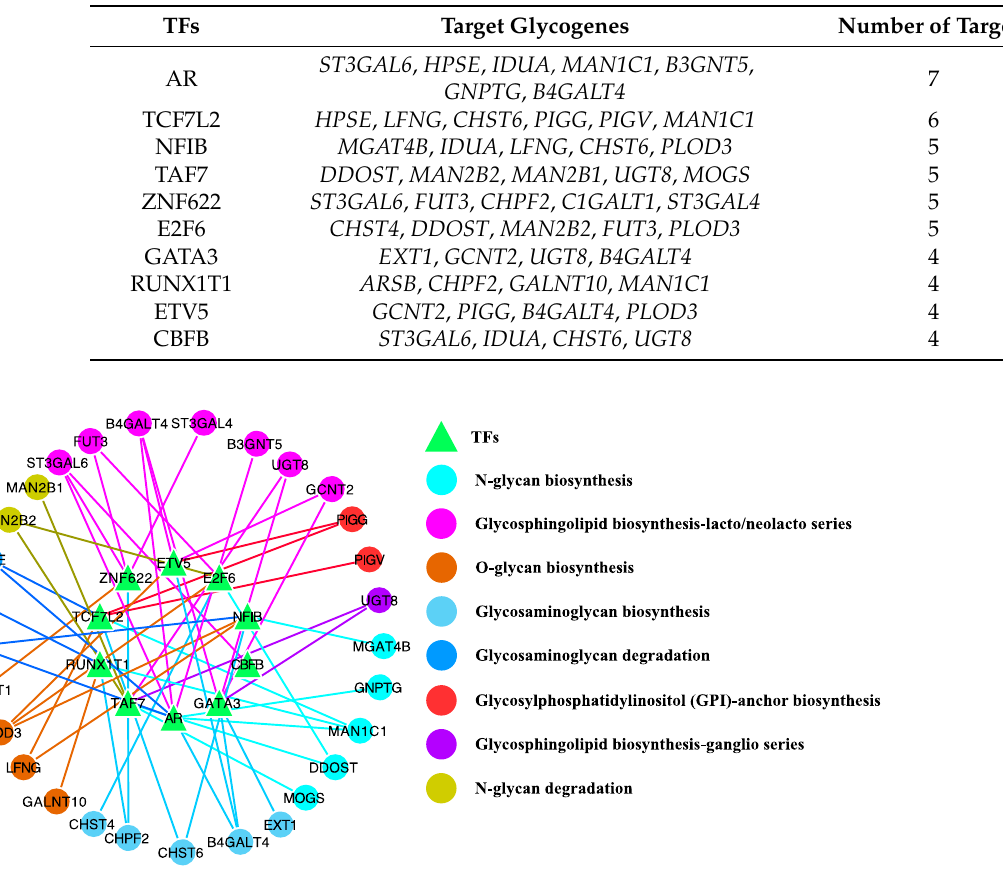
Figure 8. The TNBC-specific network for candidate TFs and glycogenes. The colour keys indicate the glycosylation pathways for the glycogenes. Table 1. Candidate transcription factors (TFs) with corresponding target-TNBC-specific glycogenes.